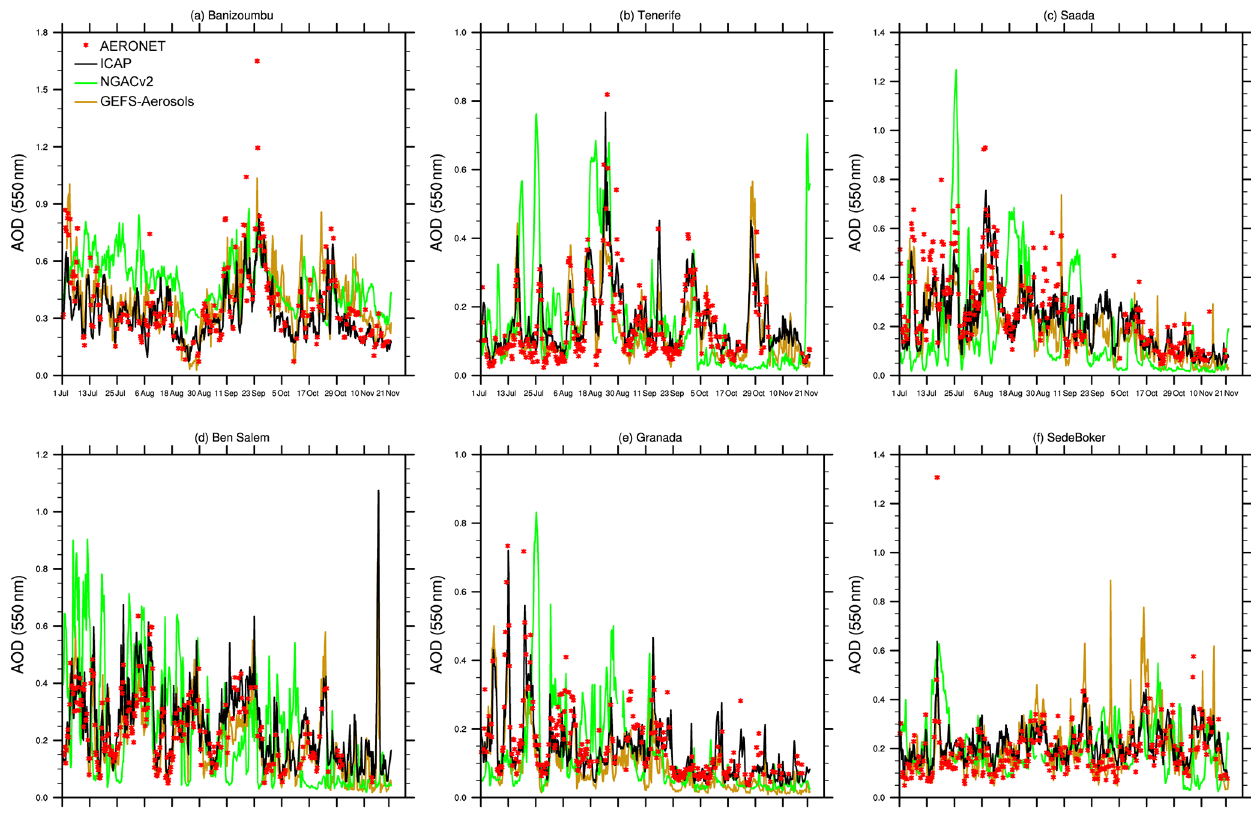
Figure 11. Day-1 AOD forecasts of GEFS-Aerosols, ICAP, and NGACv2 verified against AERONET sites in dust source regions and surrounding downwind areas during 5 July–30 November